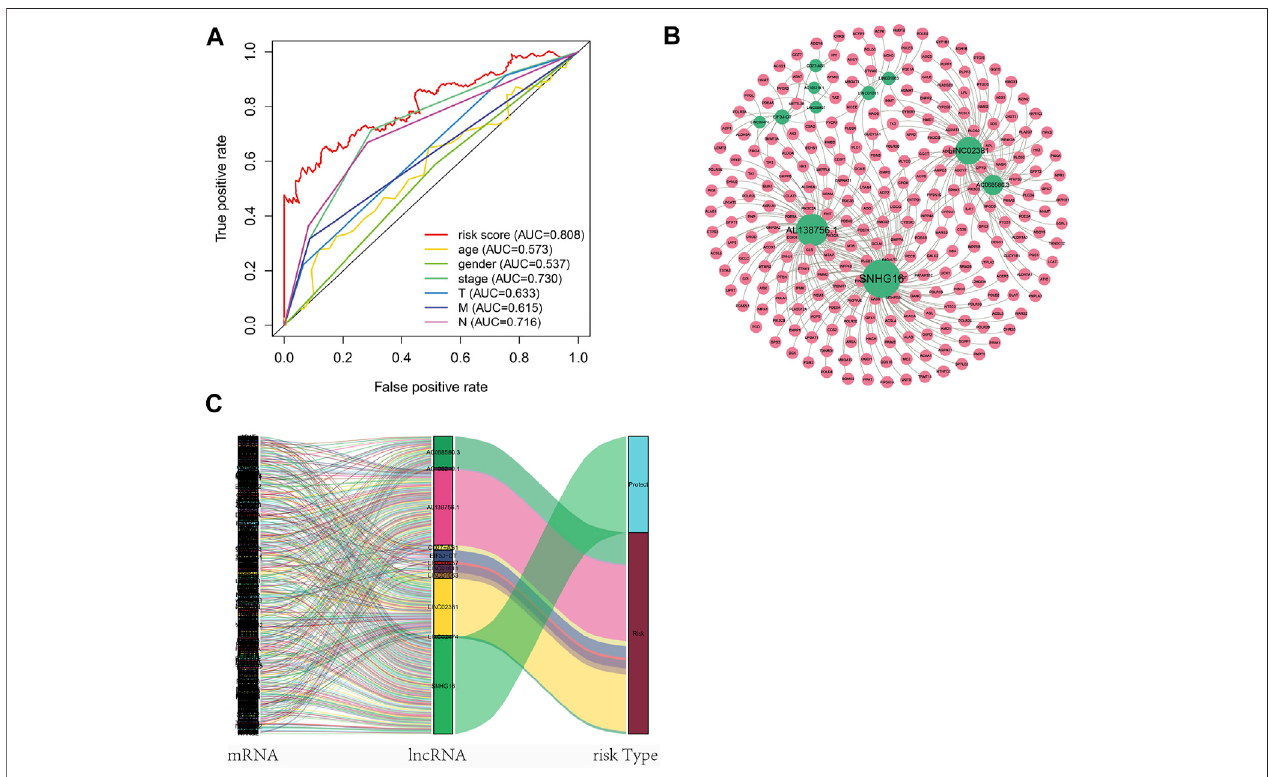
FIGURE 6 | Autophagy-related lncNRAs and their target genes in CRC. (A) The ROC curve of each factor. (B) Network of autophagy-related lncNRAs and their target genes. (C) Sankey diagram of lncRNAs and linked genes.